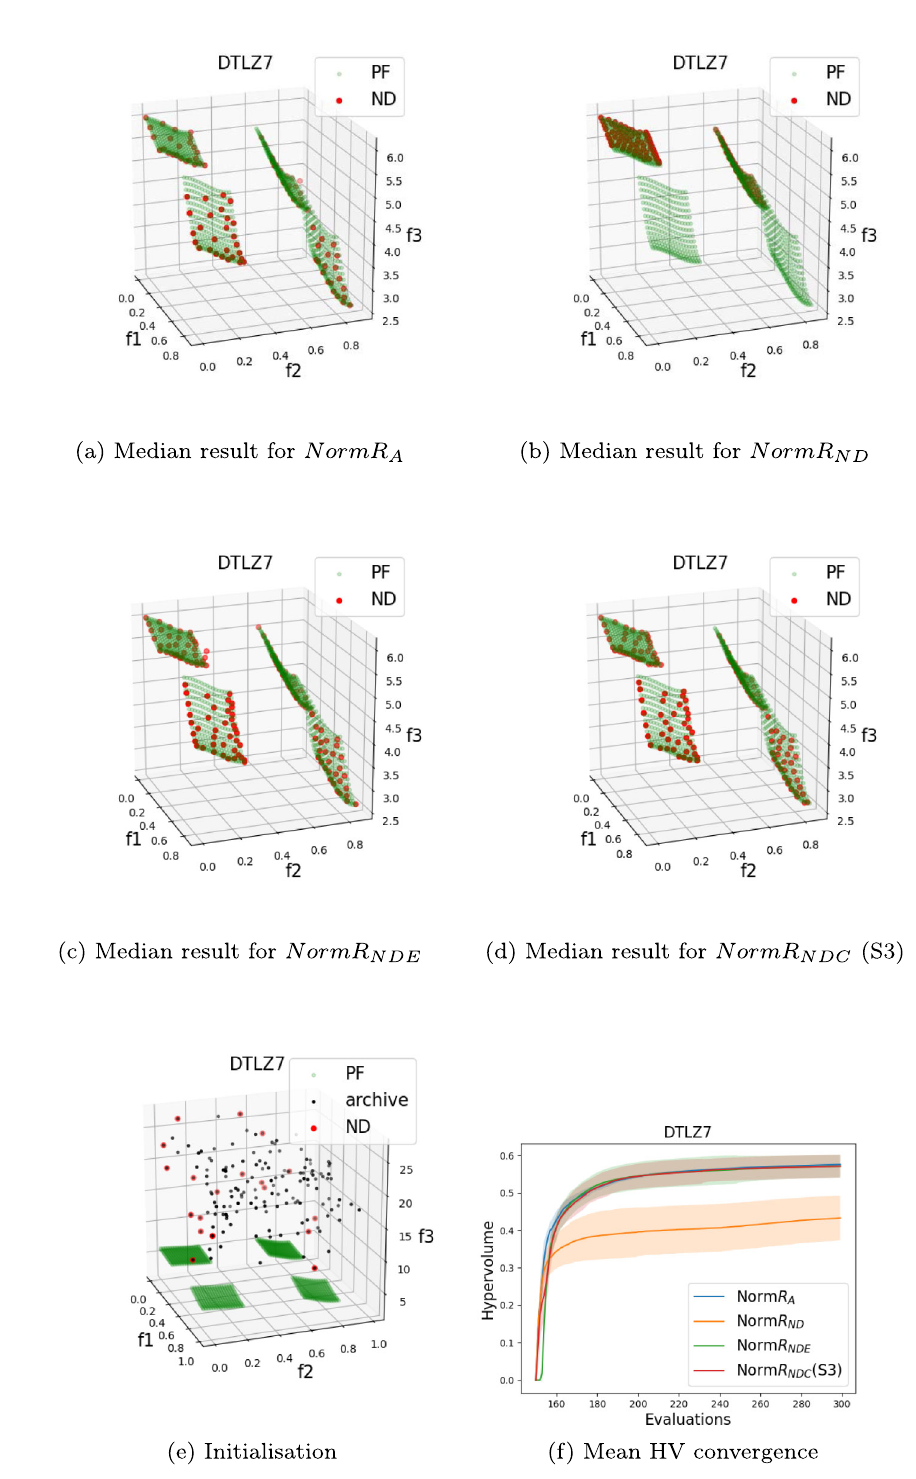
Fig. 7 Typical scenario observed for 3-objective DTLZ7